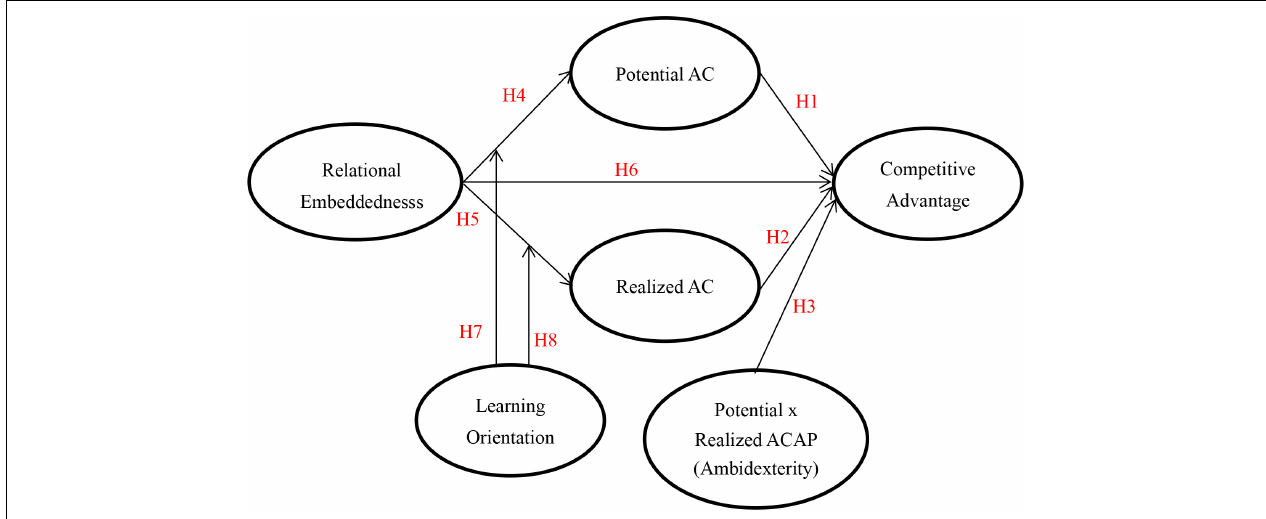
FIGURE 1 | Research framework.